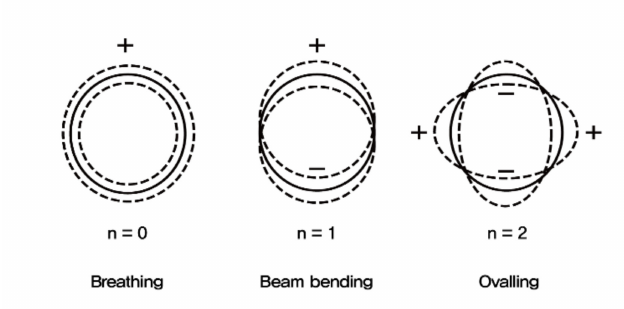
Figure 1. Coupled vibration modes of fluid and